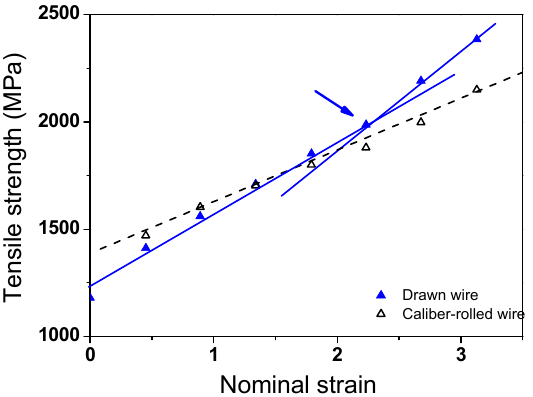
Figure 16. Comparison of the tensile strength of the drawn and caliber-rolled pearlitic steel with nominal strain. The arrow indicates the transition point of the increase in tensile strength of the drawn wire.